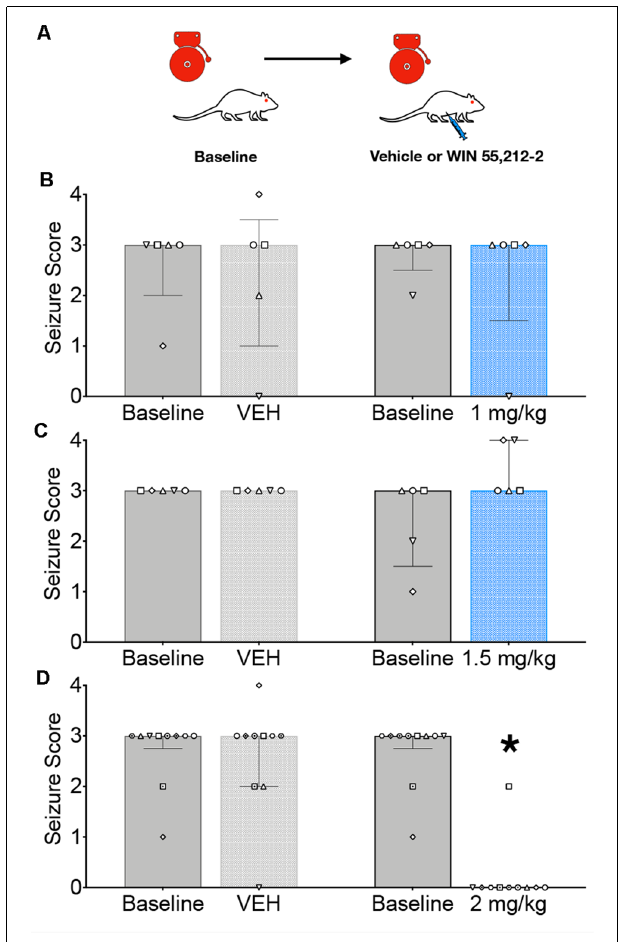
FIGURE 1 | Systemic administration of the CB1/2 receptor agonist, WIN 55,212-2 (WIN) attenuates audiogenic seizures in genetically epilepsy-prone rats (GEPRs). (A) Schematic of the testing scheme; animals were tested with a baseline test session before a vehicle-treated session. On a separate day, animals were tested on a baseline session and then with one of three doses of WIN. The testing order was counterbalanced across subjects. (B) Against audiogenic seizures (AGS) scores showing baseline sessions and comparing vehicle (left) and 1 mg/kg WIN (right). (C) AGS scores showing baseline sessions and comparing vehicle (left) and 1.5 mg/kg WIN (right). (D) AGS scores showing baseline sessions and comparing vehicle (left) and 2 mg/kg (right). Bars indicate median and interquartile range, symbols show individual subjects. * p < 0.05, according to Friedman test followed by Dunn’s post hoc test.